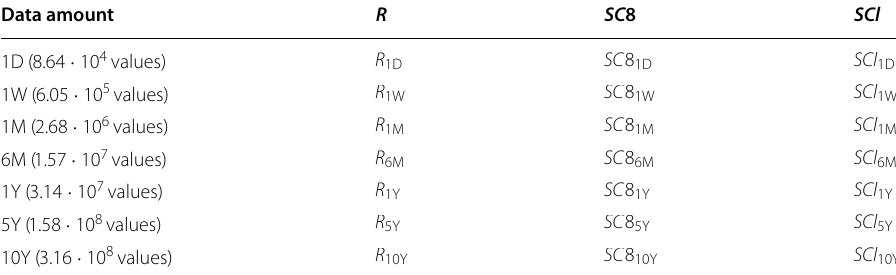
SC 8 Spark with eight processing cores on a single computer, SCl Spark on the computing